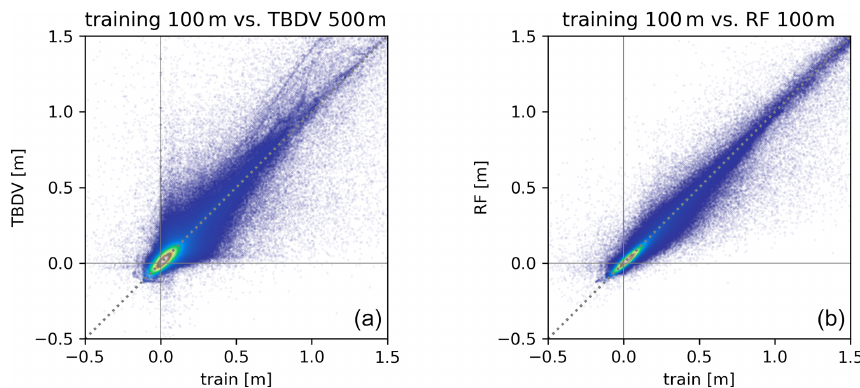
Figure 8. Scatterplots for the example of TBDV mean ff : comparing the training data (i.e. the TBDV in 100m) with the actual TBDV in 500m (a) , and with the RF downscaling results in 100m (b) for the five training